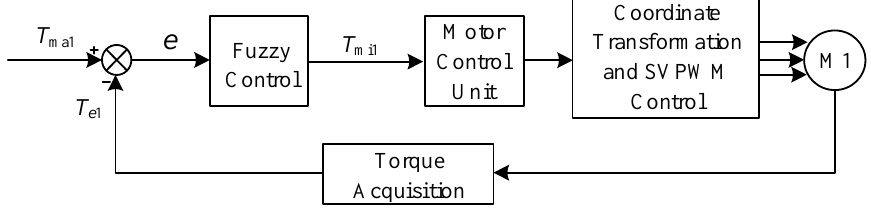
Figure 5. Control block diagram of torque collaborative control 1.